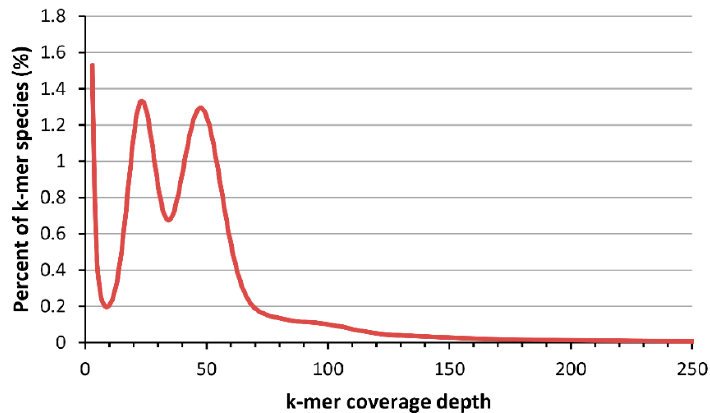
Figure 2. Distribution of 17-mer frequency of B. platyphylla .